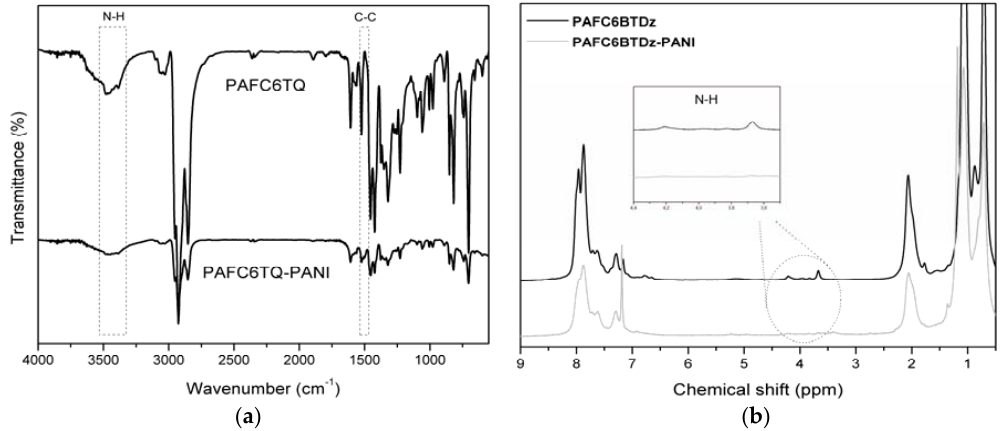
Figure 1. ( a ) FTIR spectra of PAFC6TQ and PAFC6TQ ‐ PANI ; ( b ) 1 H NMR spectra of PAFC6BTDz and PAFC6BTDz ‐ PANI .